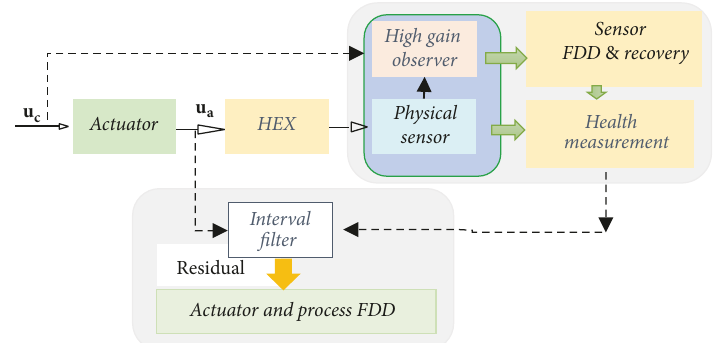
Figure 4: Proposed FDD